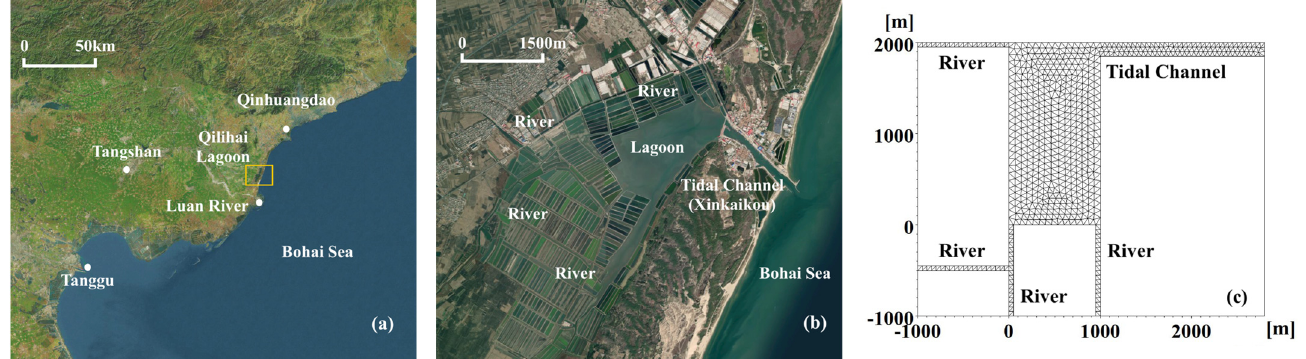
Figure 1. ( a ) Location of Qilihai Lagoon; ( b ) main parts of Qilihai Lagoon system, including lagoon, four adjacent rivers, and one tidal channel; ( c ) computational meshes of the ideal model with simplified bathymetry and geometry based on a field survey.